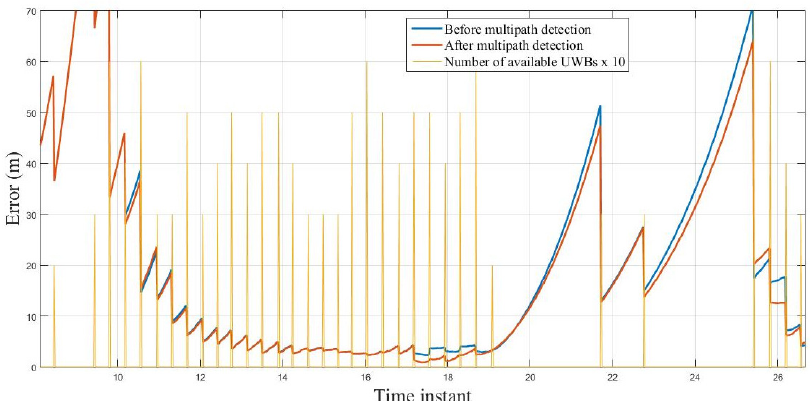
Figure 23. View1: Zoomed view of Figure